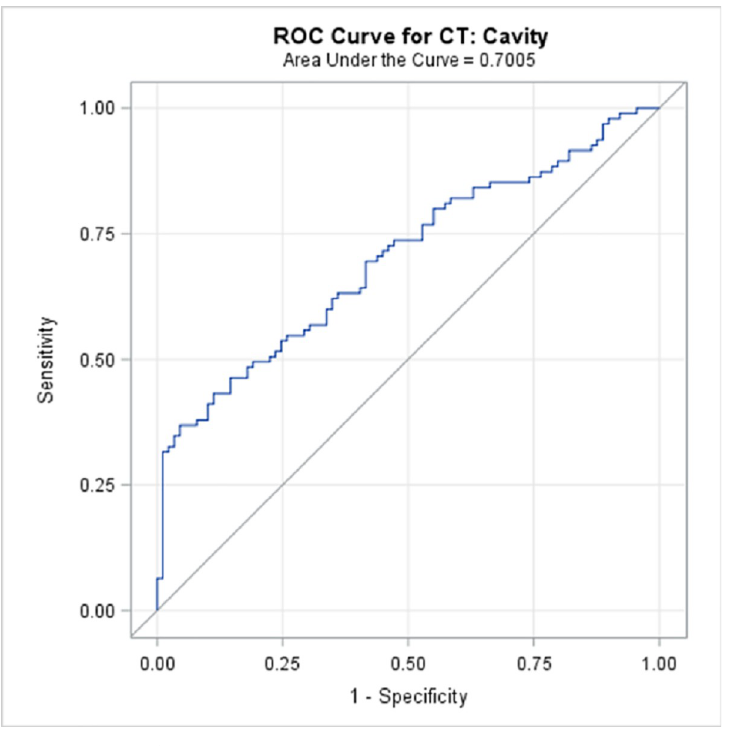
Fig 7. ROC Curve for CT: Cavity.